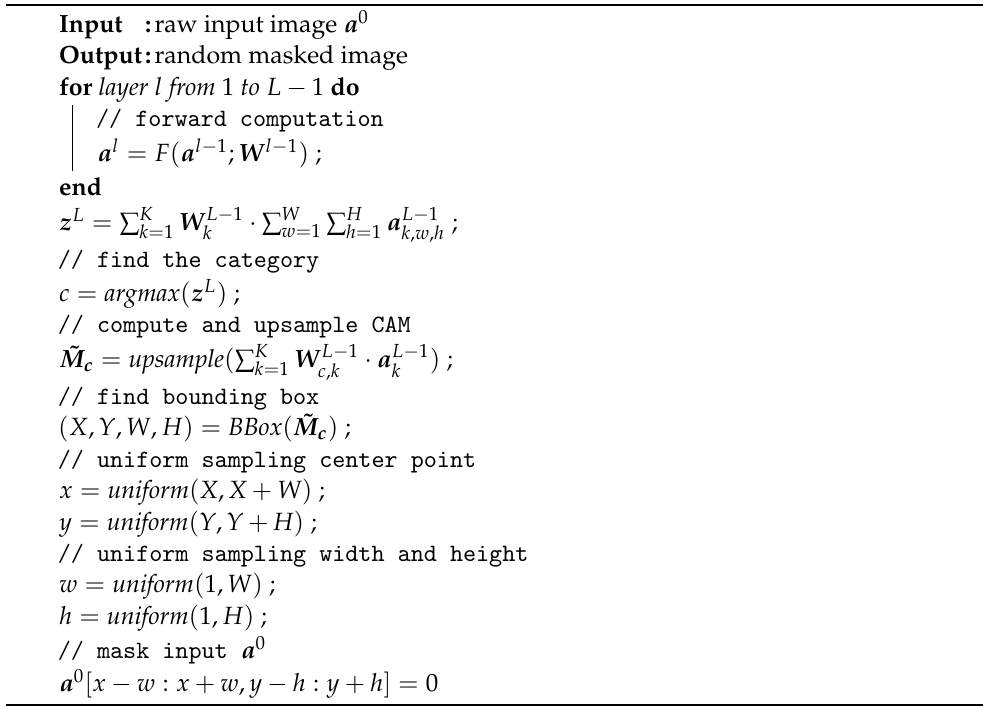
Algorithm 1: Algorithm of the proposed GRM method for the classification